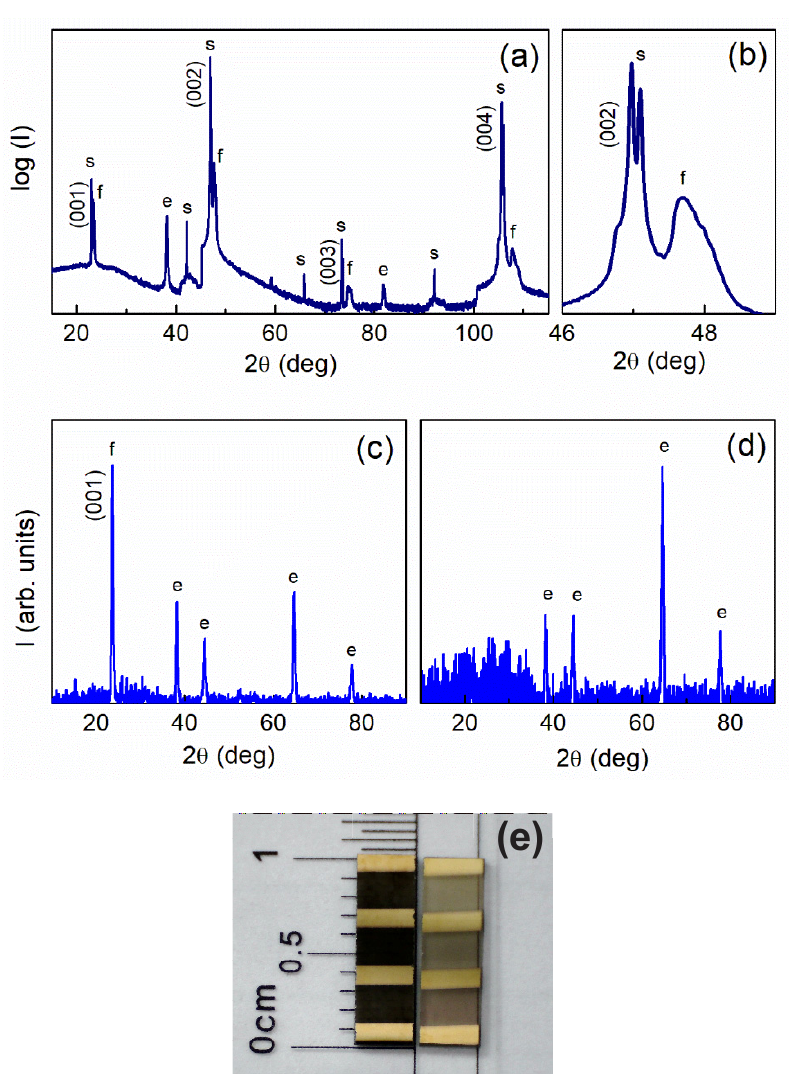
Figure 1. X-ray diffraction analysis of the studied films: ( a , b ) Bragg–Brentano θ –2 θ scans and ( c , d ) grazing incidence scans of the NNO films on ( a – c ) LSAT and ( d ) SiO 2 substrates. Diffraction peaks from the films, the LSAT substrate and the Au electrodes are marked by f, s, and e, correspondingly. Details of the (002) peaks are shown in ( b ). ( e ) Photo of the films: the darker epitaxial film on LSAT is on the left side.